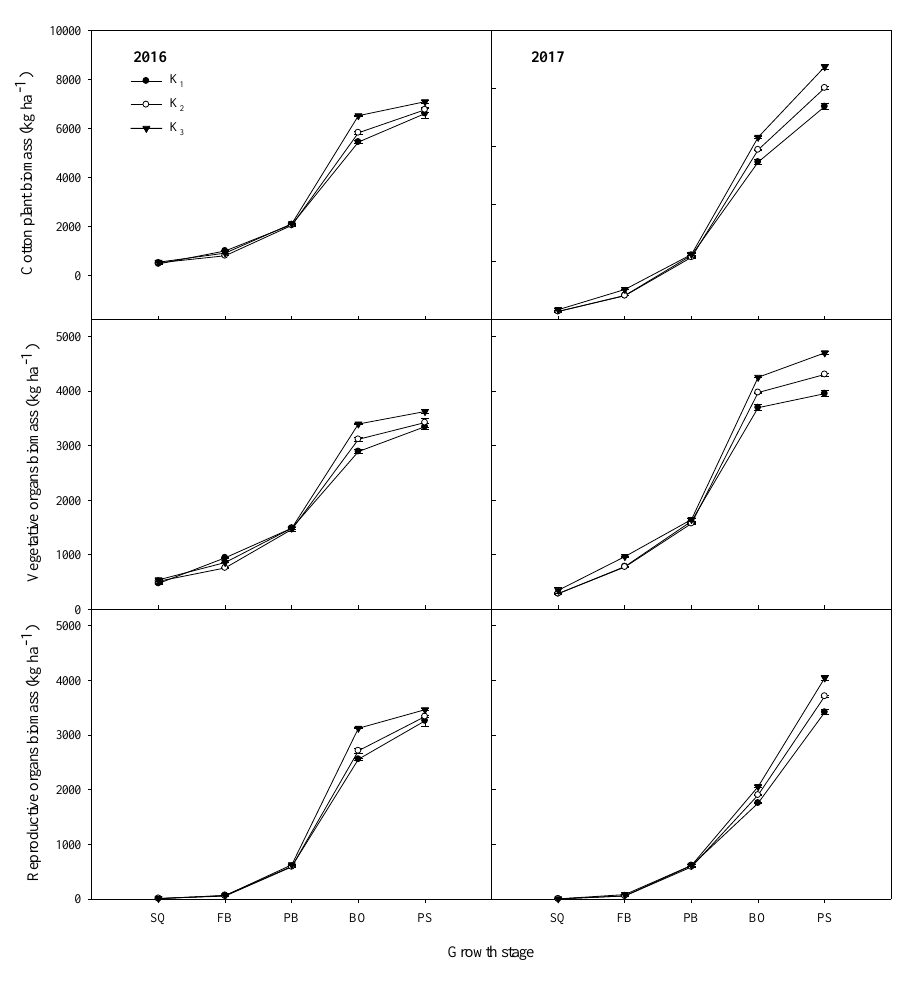
Figure 1. Cotton plant, vegetative parts, reproductive parts, and reproductive related parts biomass of field-grown cotton influenced by K fertilizer amounts at different growth stages in 2016. SQ, FB, PB, BO, and PS indicate squaring (51 days after emergence (DAE)), first bloom (66 DAE), peak bloom (81 DAE), boll opening (128 DAE), and plant senescence (168 DAE) stage, respectively. Error bar plus shows